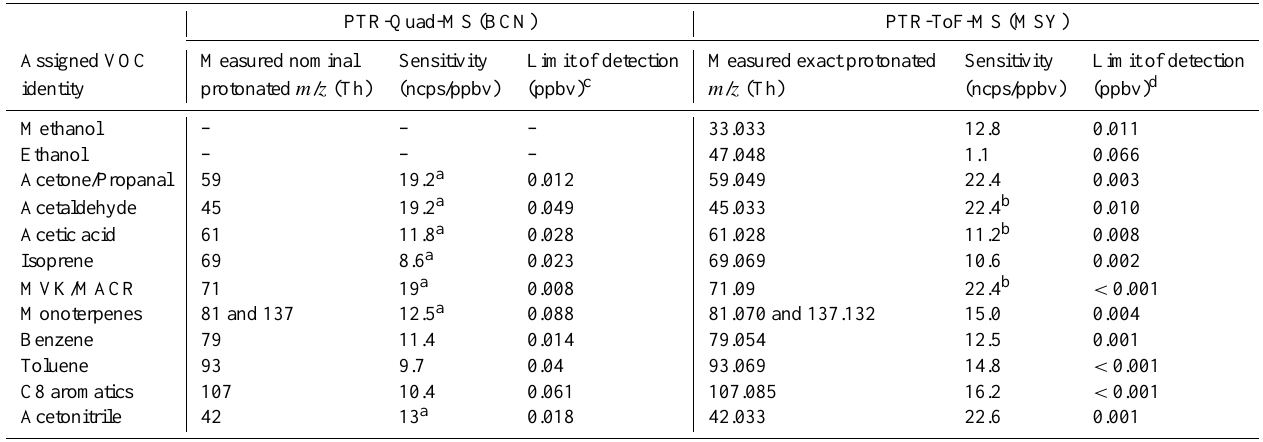
Table 1. Mass over charge ratios ( m / z ) measured with the different PTR-MS systems and the corresponding VOC identities assigned to them. The mean sensitivity and the limit of detection for each VOC are displayed. Sensitivities shown are transmission corrected and normalized to the primary ion signal. All major molecular fragments were considered. Detection limits (DL) were inferred from a signal-to-noise ratio of 2 by DL=2 × SD blank /sensitivity, with SD blank being the standard deviation of background count rates, as reported elsewhere (Karl et al.,